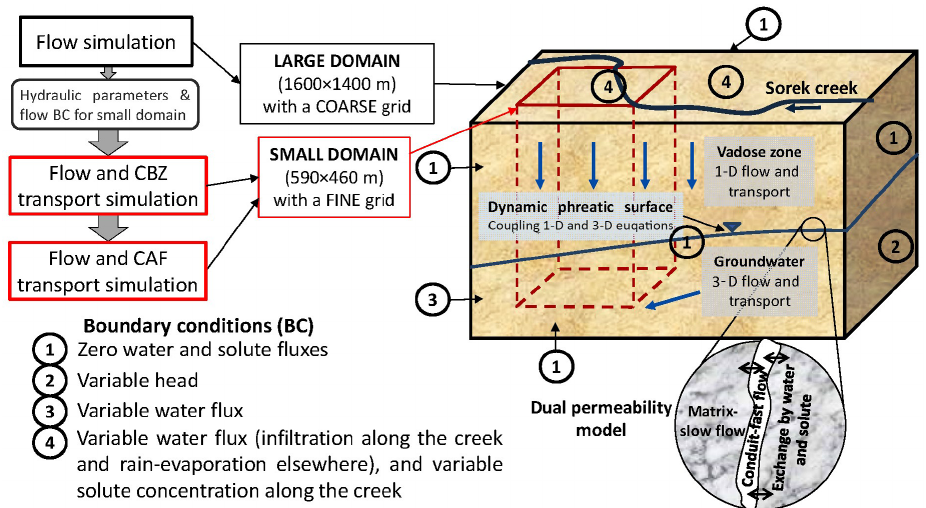
Figure 2. Model conceptual